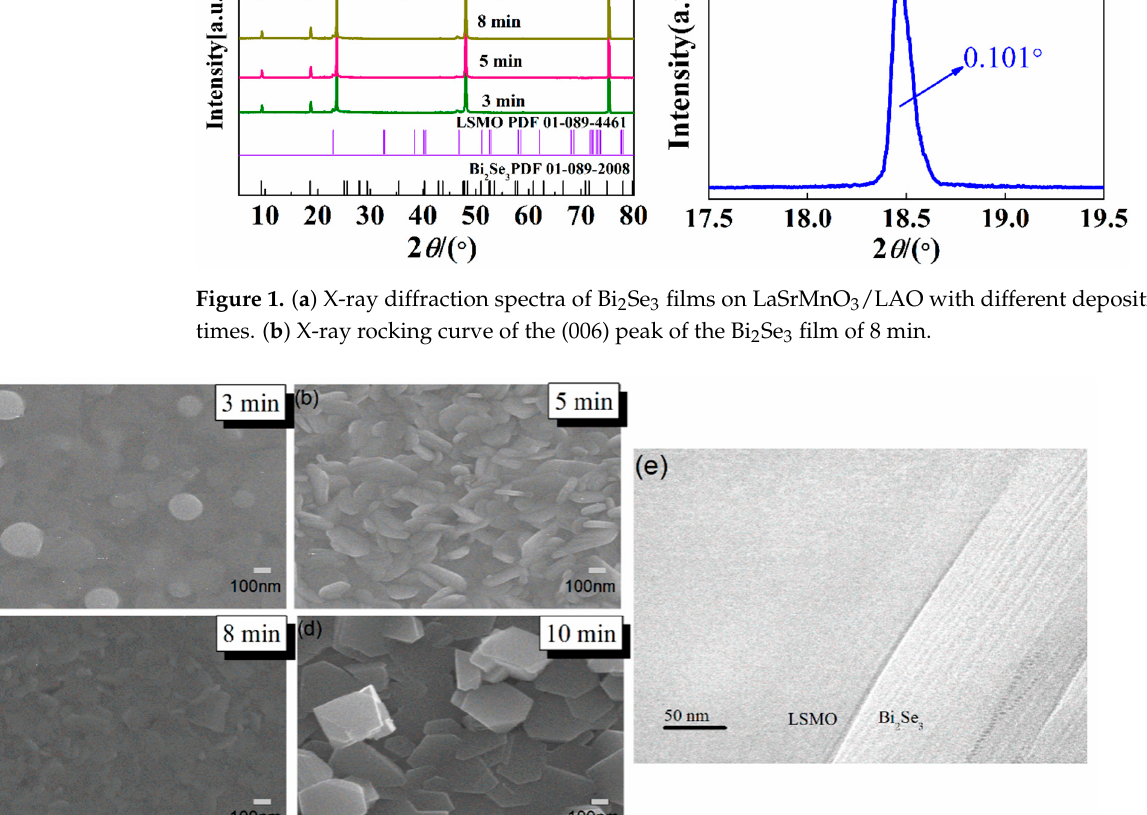
Figure 1. ( a ) X-ray